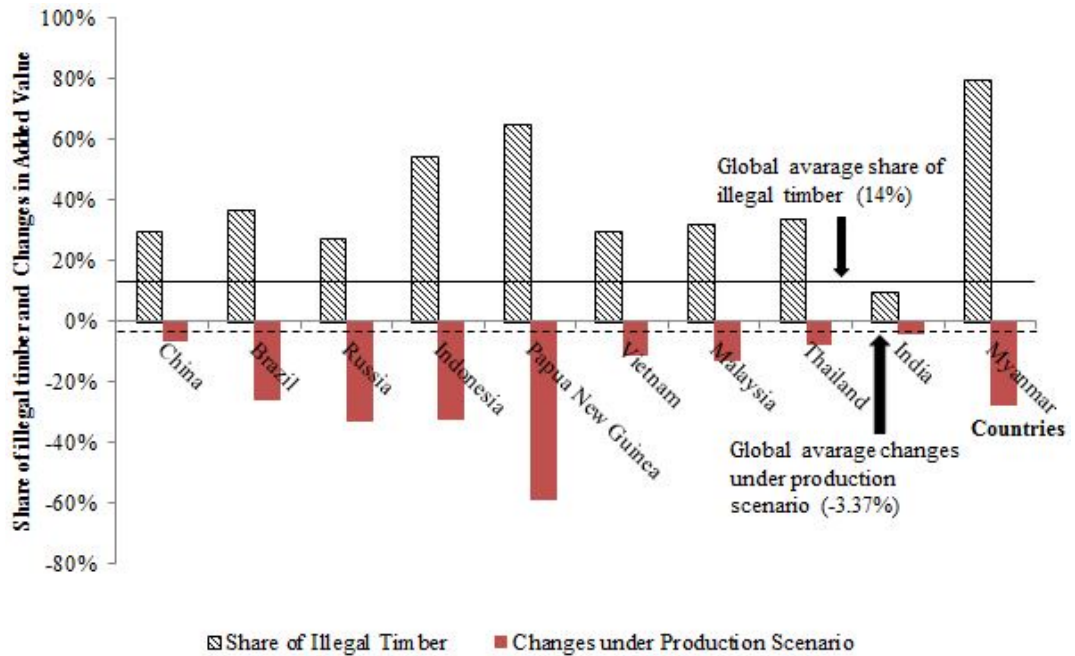
Figure 6. Shares of illegal timber production in the domestic harvested timber and changes in added value under the production scenario in the top 10 producing